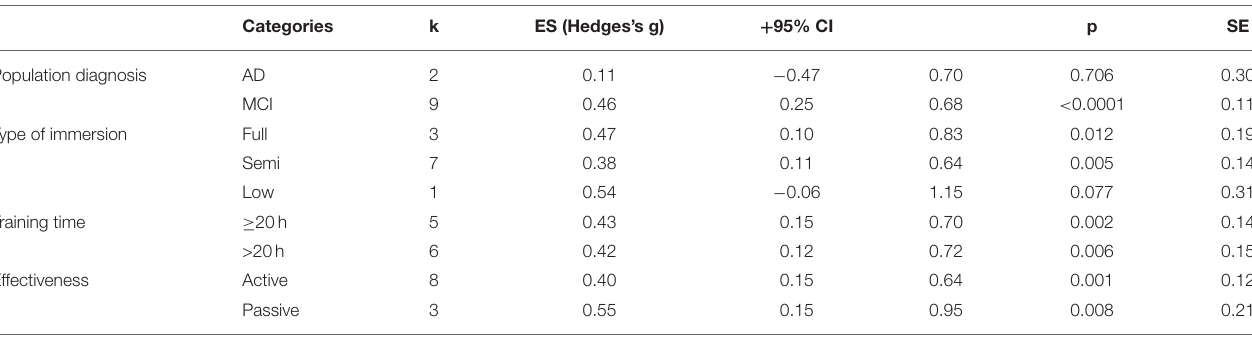
TABLE 5 | Effect sizes of subgroup according to study